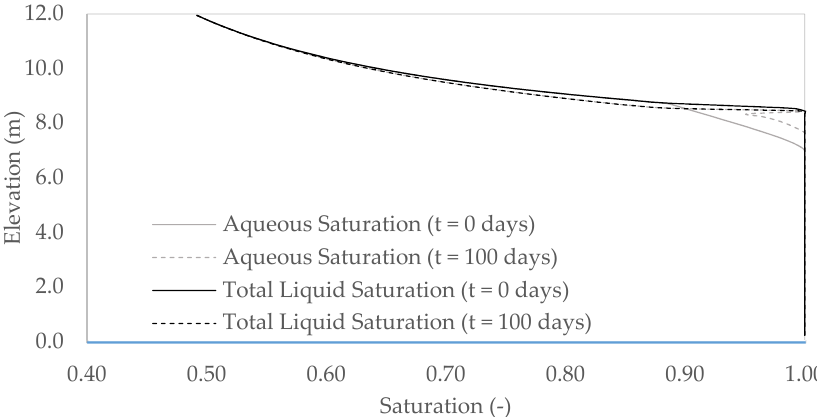
Figure 11. Aqueous and total saturation variation (initial and final) in TE8 under 24.93 kPa for silty sand.